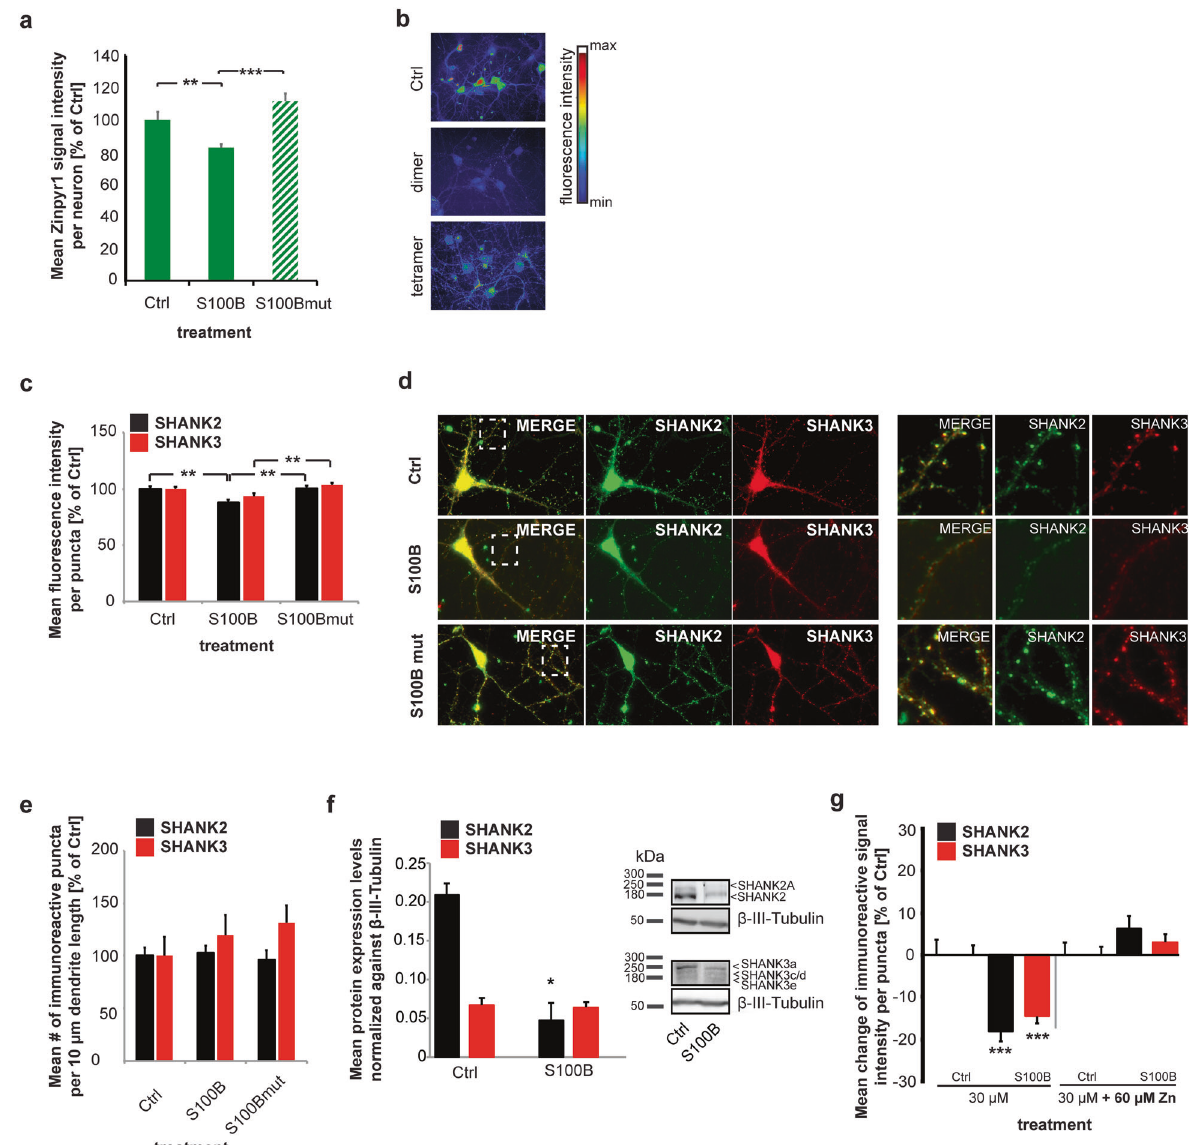
Fig. 1 Increased levels of S100B sequester zinc ions. a Treatment of hippocampal cultures with 30 μ M S100B or S100Bmut for 24 h at DIV10. The mean intracellular signal intensity of Zinpyr1 fl uorescence is shown. Treatment of hippocampal cultures with S100B signi fi cantly reduces the free intracellular Zn 2 + concentration assessed by the analysis of 35 cells per condition. No signi fi cant decrease in intracellular Zinpyr1 = 8.86; p < 0.0001; Post-hoc analysis: control vs. S100B, fl uorescence can be observed in cultures treated with S100Bmut (one-way ANOVA, F 2,77 p = 0.0037; control vs. S100Bmut, p = 0.2469; S100B vs. S100Bmut, p < 0.0001). b Exemplary images showing signal intensities of Zinpyr1 in a color-coded manner. c – g Increased levels of S100B lead to a decrease in zinc-dependent SHANK proteins at the synapse. c Treatment of hippocampal cultures with 30 μ M S100B for 24 h. The signal intensity of SHANK2 is signi fi cantly reduced 24 h after exposure to S100B. Similarly, the signal intensity of SHANK3 puncta shows a trend toward a reduction. No signi fi cant reduction of SHANK2 and SHANK3 was observed 24 h after applying S100Bmut. For all analyses, 8 – 10 cells per condition were used (one-way ANOVA: SHANK2: F 2,27 = 502.009, p = 0.001; Post-hoc analysis: Control vs. S100B p = 0.0013, S100B vs. S100Bmut p = 0.0029; Shank3: F 2,27 = 278.257, p = 0.005; Post-hoc analysis: Control vs. S100B p = 0.497, S100B vs. S100Bmut p = 0.0037) ( n = 10 cells per condition). d Exemplary images showing anti-SHANK2 and SHANK3 staining of hippocampal neurons 24 h after treatment with S100B and S100Bmut. e The mean number of immunoreactive signals per dendrite length was evaluated. No signi fi cant alterations were detected. f Using Western blot experiments (from three different preparations), a signi fi cant decrease of SHANK2 protein levels in the crude membrane fraction can be seen ( t -test, p = 0.0265). g Cells were again treated with S100B for 24 h at DIV8. A signi fi cant reduction of SHANK2 and SHANK3 proteins is visible. This reduction was abolished in case cells were treated with 30 μ M S100B that was saturated with 60 μ M ZnCl 2 for 1 h on ice before application (one-way ANOVA: SHANK2: F 3,36 = 12.2454, p < 0.001; Post-hoc analysis: Control vs. S100B p = 0.001, S100B vs. saturated S100B p = 0.001; SHANK3: F 3,36 = 15.9105, p = 0.005; Post-hoc analysis: Control vs. S100B p = 0.001, S100B vs. saturated S100Bmut p = 0.001, p = 0.0037) ( n = 10 cells per